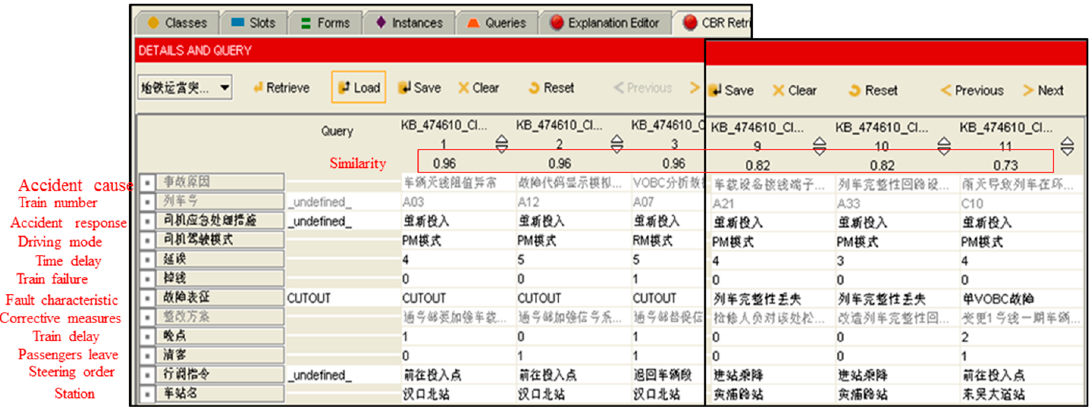
Figure 10. Retrieval results of “cutout” in descending order based on their similarity.